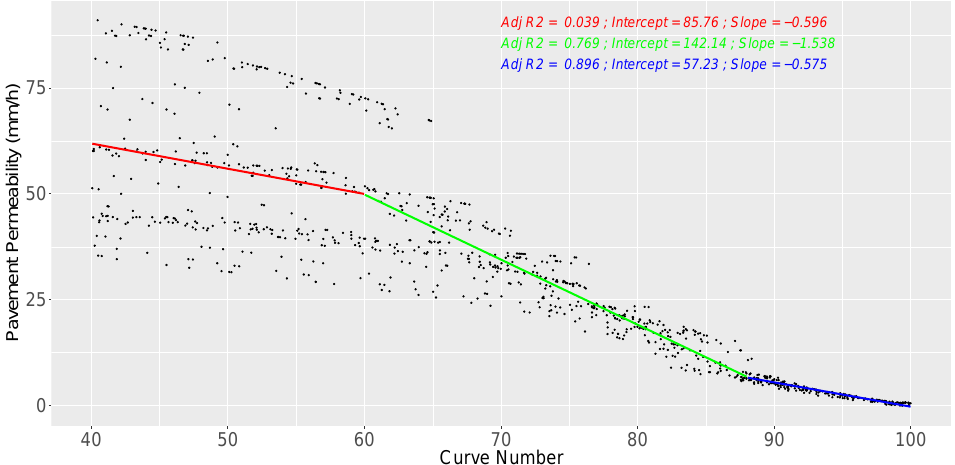
Figure 4. Pavement permeability values for fitted hydrographs in each selected CN and considered regression curves, with different colours for each proposed